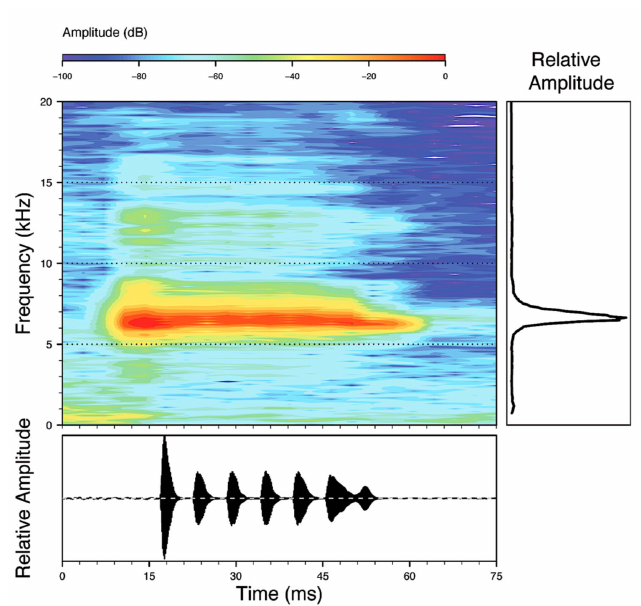
Figure 193. Call of Rulyrana flavopunctata , MZUTI 1684, recorded at Quebrada Pangayaku, 1645 m, Napo province, Ecuador. Air temperature = 19.4 ◦ C.